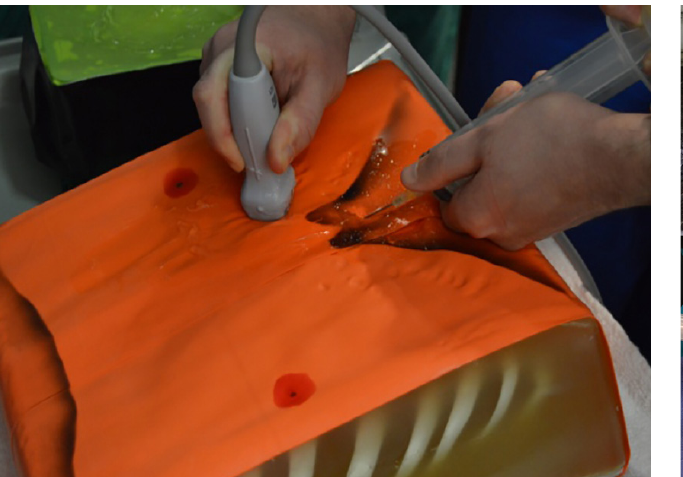
Figure 1. Original ultrasound-guided pericardiocentesis model from Daly R. et al. West J Emerg Med. 2017;18(1):114-6.